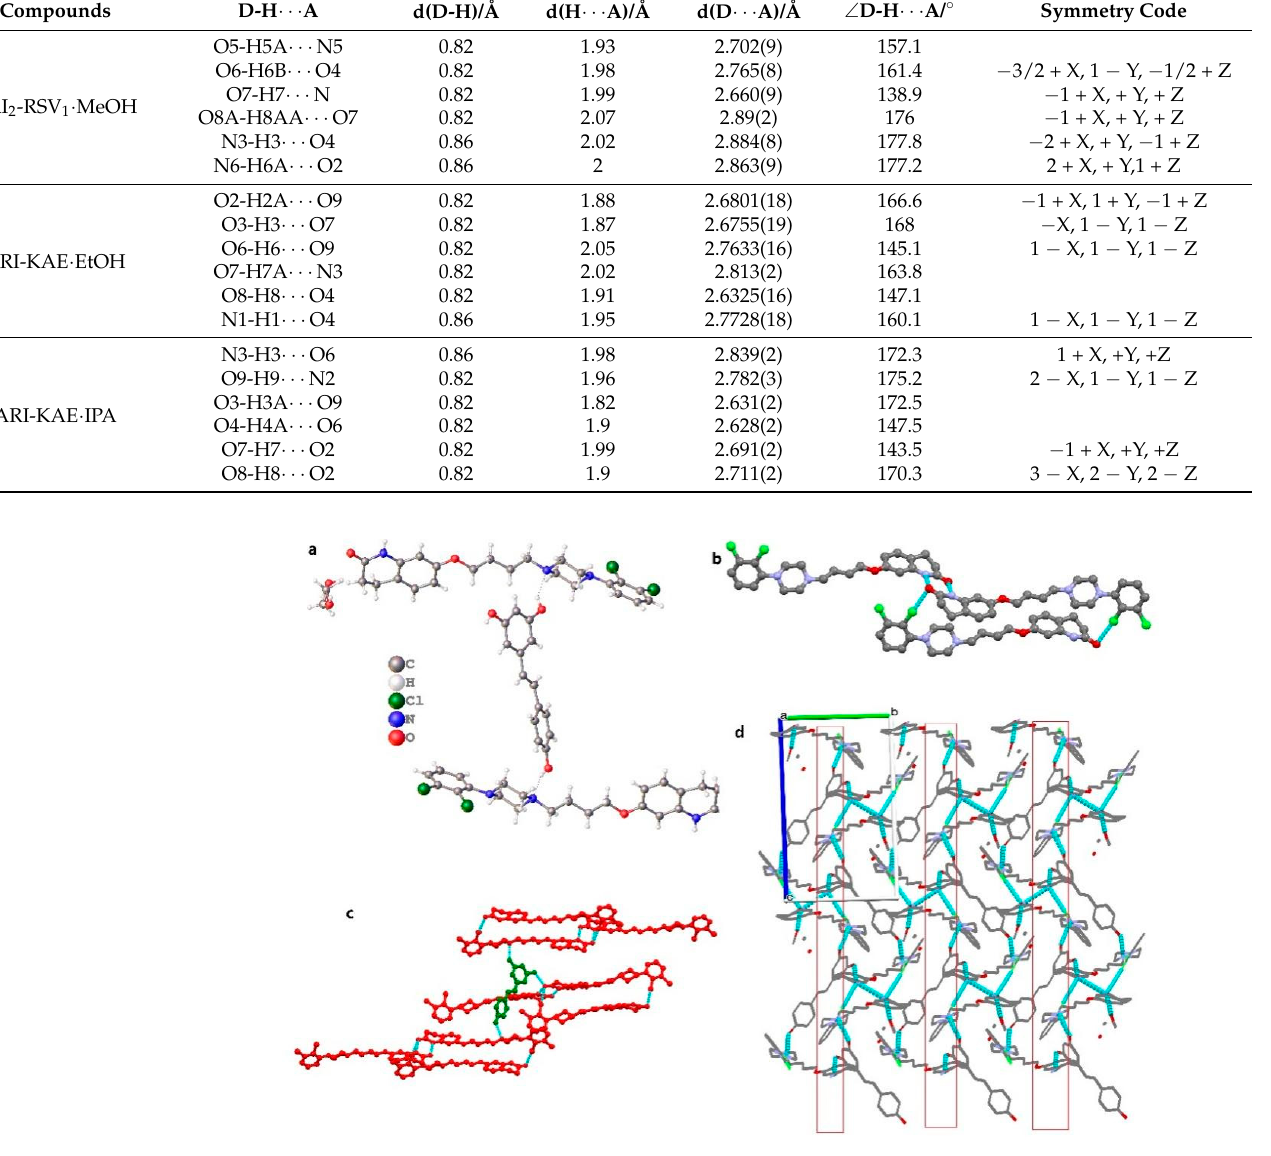
Figure 2. ( a ) The asymmetric unit for ARI 2 -RSV 1 · MeOH (methanol is disorder), ( b ) ARI tri-molecular motif, ( c ) three ARI tri-molecular motif linked to RSV, ( d ) 2D sheet along c